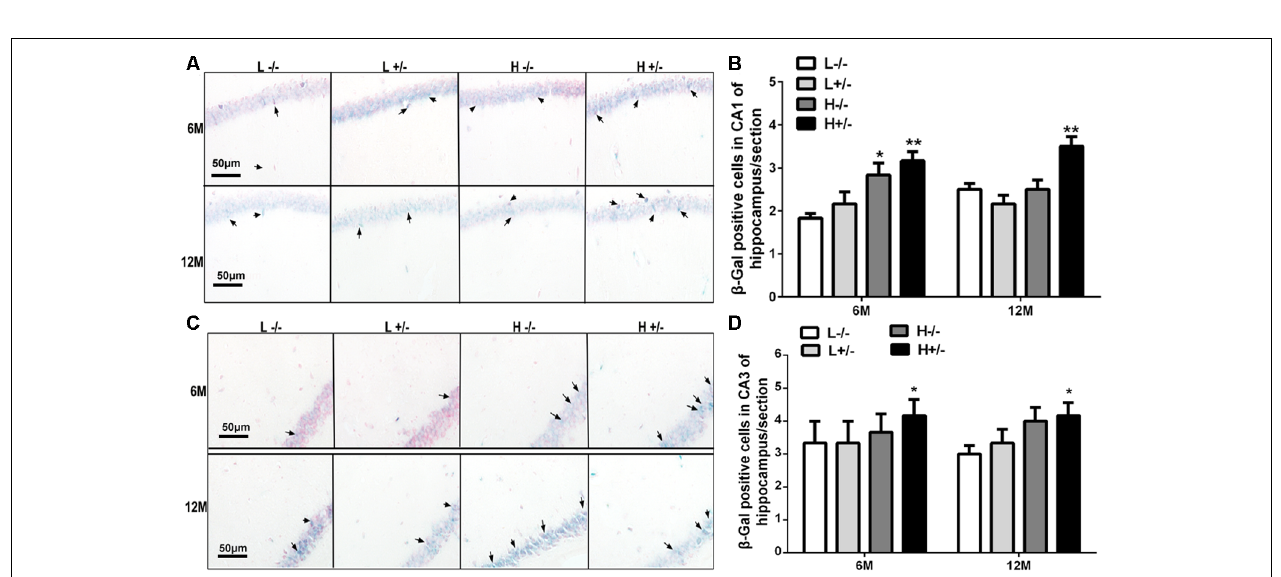
FIGURE 4 | Nerve cell aging in the hippocampi of hIAPP − / − and hIAPP − / + mice was accelerated by a high-fat diet. (A) Representative images of β -gal-positive staining in the hippocampal CA1 regions of hIAPP − / − and hIAPP + / − mice fed with a high/low-fat diet for 6 or 12 months. Black arrows indicate β -gal-positive cells. (B) Six sections per mouse were stained, and semiquantitative analysis was performed using ImageJ software. (C) Representative images of β -gal-positive staining in the hippocampal CA3 regions of hIAPP − / − and hIAPP + / − mice treated with a high/low-fat diet for 6 or 12 months. Black arrows indicate β -gal-positive cells. (D) Six sections per mouse were stained, and semiquantitative analysis was performed using ImageJ software. L − / − denotes hIAPP − / − mice on a low-fat diet; L + / − denotes hIAPP + / − mice on a low-fat diet; H − / − denotes hIAPP − / − mice on a high-fat diet; H + / − denotes hIAPP + / − mice on a high-fat diet. n = 6, ∗ p < 0.05, ∗∗ p < 0.01 compared with the L − / −